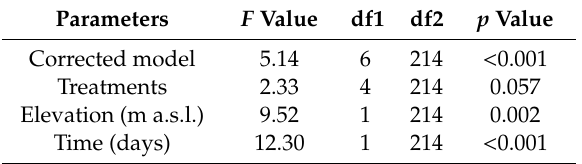
Table A1. Independent fixed e ff ects of the General Linear Mixed Model applied to the dependent variable “deepwater storage” in 20 locations of the experimental field during the irrigation period.